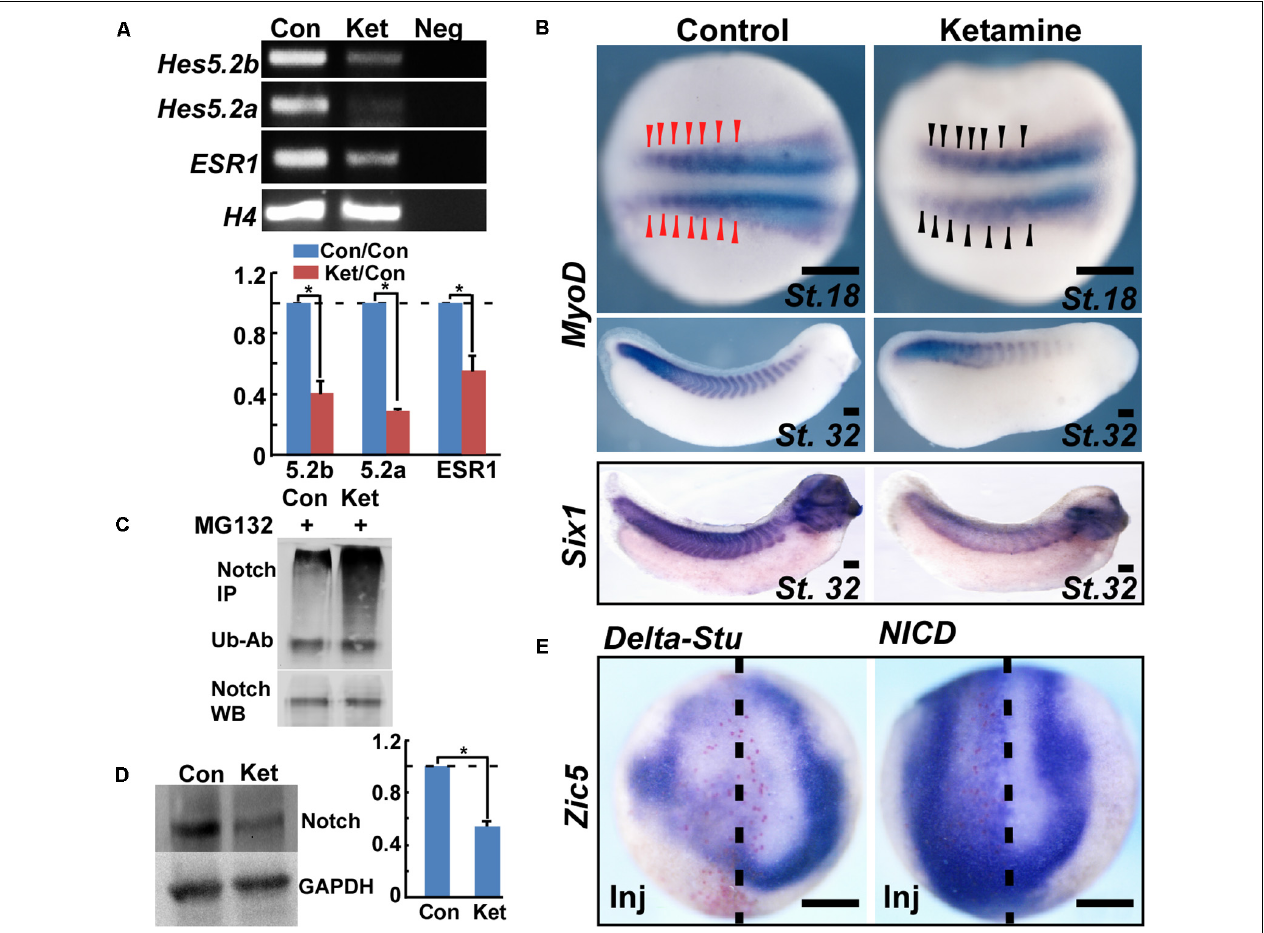
FIGURE 4 | Ketamine inhibits Zic5 through the Notch signaling pathway. (A) During NC induction, ketamine exposure down-regulated expression of Notch targeted genes including Hes5.2a , Hes5.2b , and ESR1. The number represents Mean ± SEM, N = 3, ∗ P < 0.05 by Student’s t -test. (B) In the late neurula, MyoD transcription in early somite primordium became a little bit thin and slightly reduced the signal upon ketamine exposure. At tailbud stage, ketamine led to fewer somites and a shortened body axis. The somites are labeled with in situ hybridization of MyoD , and Six1 . (C) Ketamine exposure increased the amount of ubiquitinated Notch protein in Jurkat cells. Upper part: ubiquitinated Notch proteins were immuno-precipitated (IP) with Notch-1 antibody, followed by anti-ubiquitin antibody (Ub-Ab) western blot staining. Lower part: Notch-1 loading control. (D) In Jurkat cells, ketamine exposure for 10 h reduced Notch protein level. The number represents Mean SEM, N = 3, P < 0.05 by Student’s t -test. (E) During NC induction, inhibiting Notch signaling by microinjection of 1 ng Delta-stu mRNA at 4-cell stage blocked Zic5 expression. Activation of Notch signaling by microinjection of 800 pg NICD mRNA into one dorsal cell at 4-cell stage induced ectopic Zic5 expression. Scale bar: 100 µ